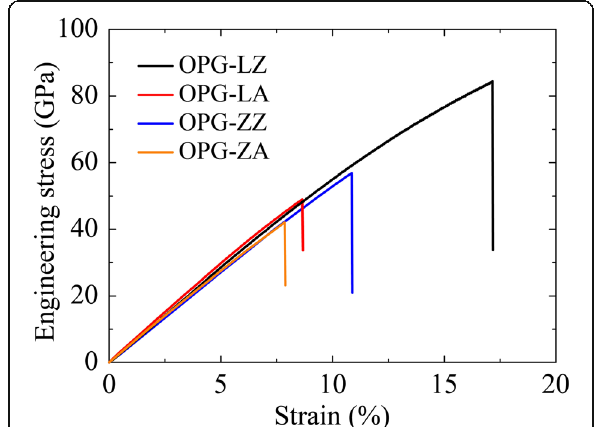
Fig. 9 Stress-strain relationships of the two carbon allotropes along the zigzag and the armchair